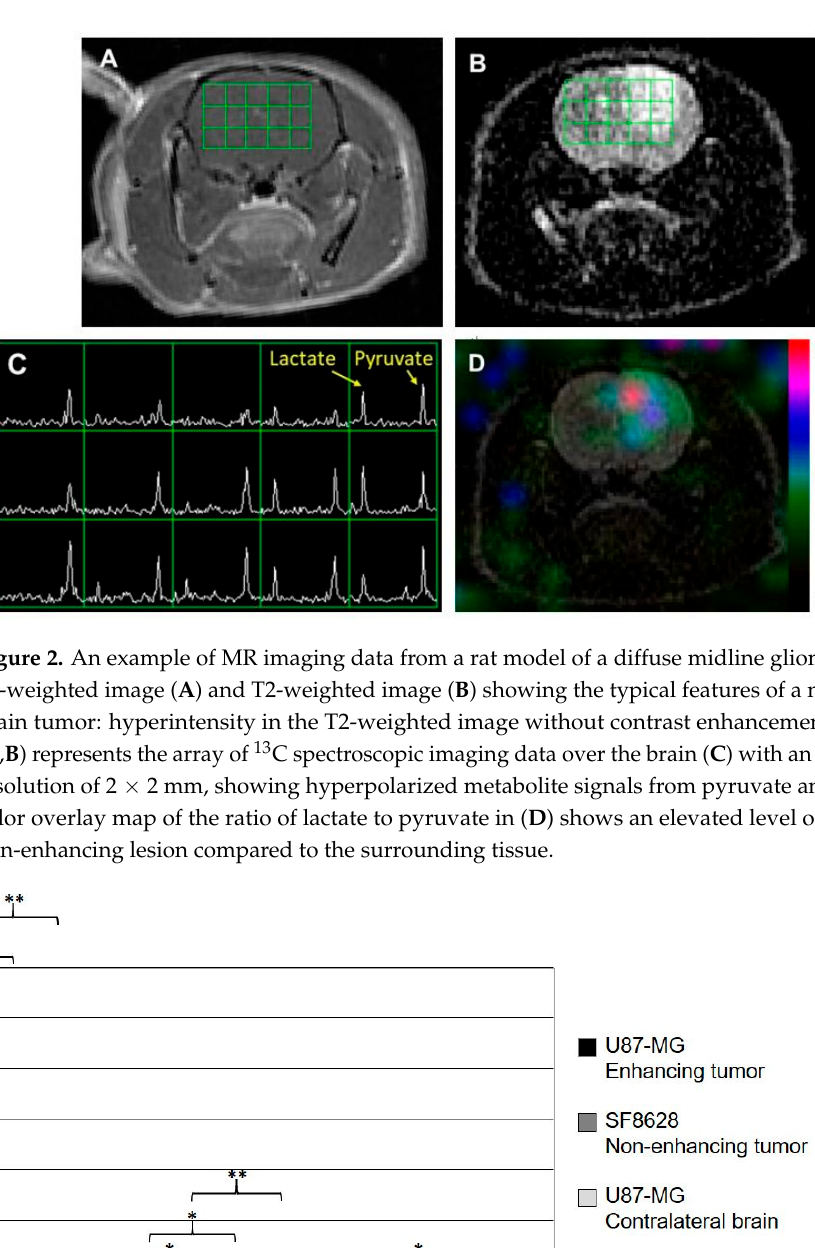
Figure 1. An example of MR imaging data from a rat model of glioblastoma. A post-gadolinium T1- weighted image ( A ) and T2-weighted image ( B ) showed the typical features of a high-grade glioma: contrast enhancement in the post-contrast T1-weighted image and hyperintensity in the T2- weighted image. The grid in ( A , B ) represents the array of 13 C spectroscopic imaging data over the brain, with an in-plane voxel resolution of 2 × 2 mm ( C ). Each voxel in ( C ) contains the hyperpolar- ized 13 C pyruvate signal and its metabolic product, lactate. The color overlay map of the ratio of lactate to pyruvate in ( D ) shows a highly elevated level of lactate in the enhancing lesion.